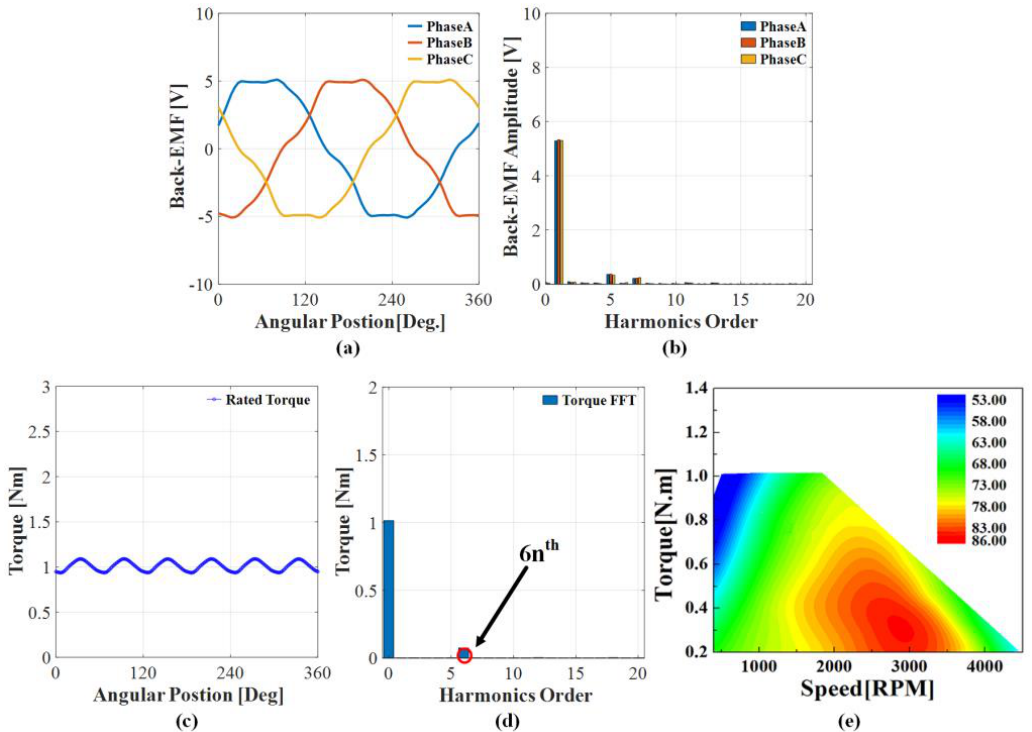
Figure 7. Load analysis result: ( a ) load back EMF waveform, ( b ) load back EMF FFT result, ( c ) torque waveform, ( d ) torque FFT result, and ( e ) efficiency map.